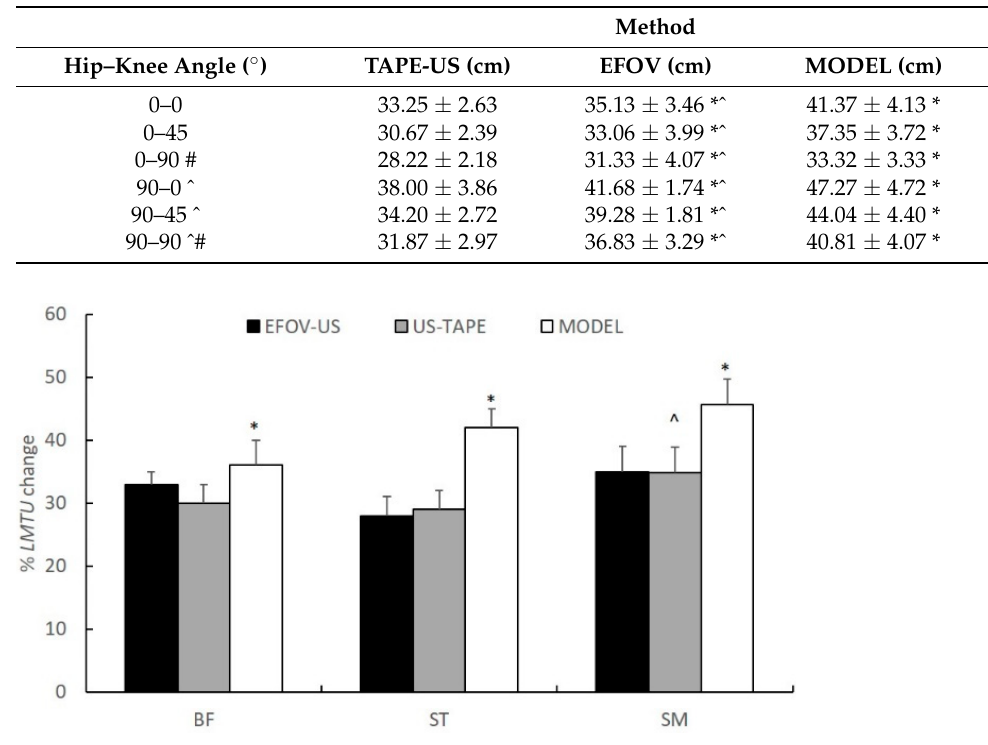
Figure 4. Mean (SD) maximum percentage change in muscle-tendon unit length of the biceps femoris long head (BFlh), semitendinosus (ST), and semimembranosus (SM) relative to the shortest muscle length (hip flexed 0 ◦ and knee flexed 90 ◦ ), estimated using EFOV-US, TAPE-US, and MODEL methods (* significant different compared with EFOV-US and TAPE-US methods, collapsed across muscles ˆ significantly different compared with BFlh and ST, collapsed across methods p < 0.05).